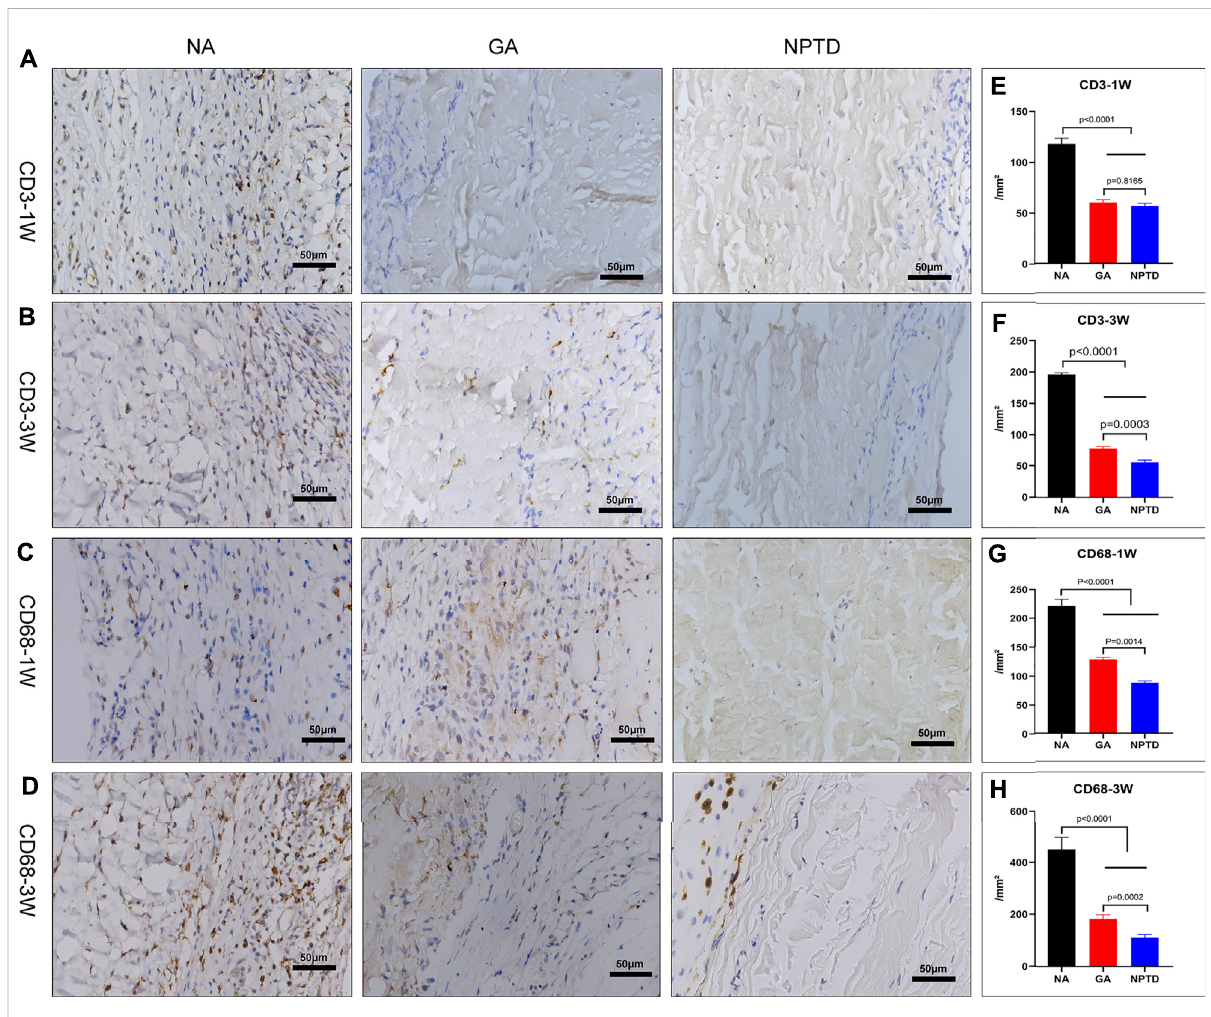
FIGURE 8 Characterization of the host response of various samples after subcutaneous implantation for 1 week and 3 weeks. The images show the immunohistochemical stainingofCD68andCD3 (A,B,C,D) ,ontherightsideofthecorrespondingimageisthesemi-quantitativeresult (E – H) .Inthe fi rst week, CD3 + cells were not signi fi cantly different between the GA and NPTD groups, while in the third week, there were fewer CD3 positive cells in the NPTD group than in the GA group. The results showed the reduced CD68 + in fl ammatory cell in fi ltration in the NPTD group compared to the GA and NA groups at 1 week and 3 weeks. Statistical analysis was performed by one-way analysis of variance